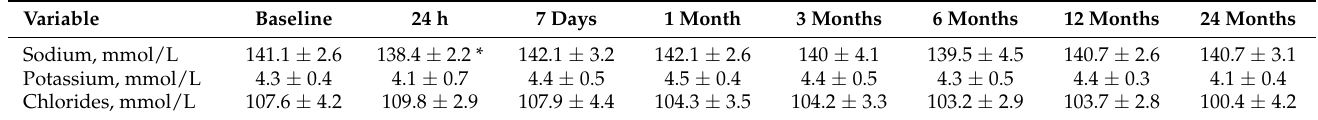
Table 2. Sequential change in serum electrolytes after LAAC from baseline to 24 months follow up.